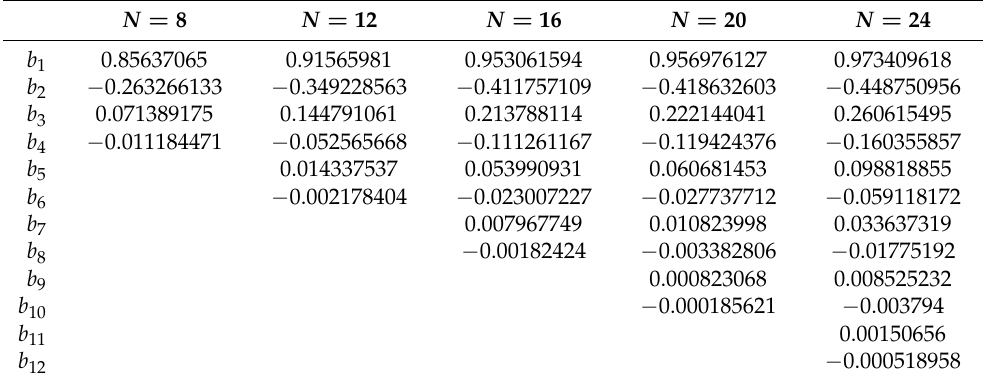
Table 4. The finite-difference coefficients for the first derivative optimized by KH.